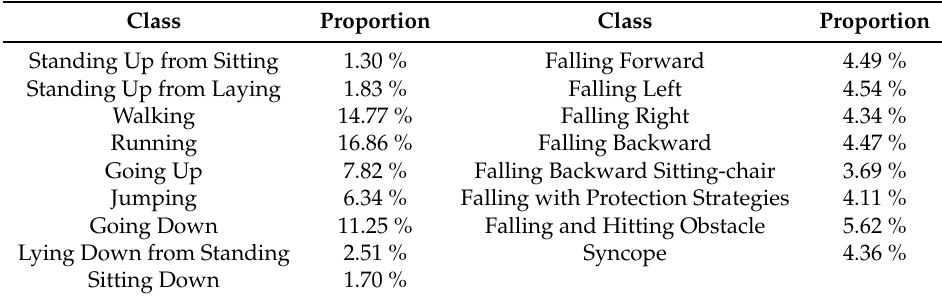
Table 2. Classes of the UniMiB-SHAR dataset and their respective proportions. ADLs and falls are provided in the left and right column, respectively.